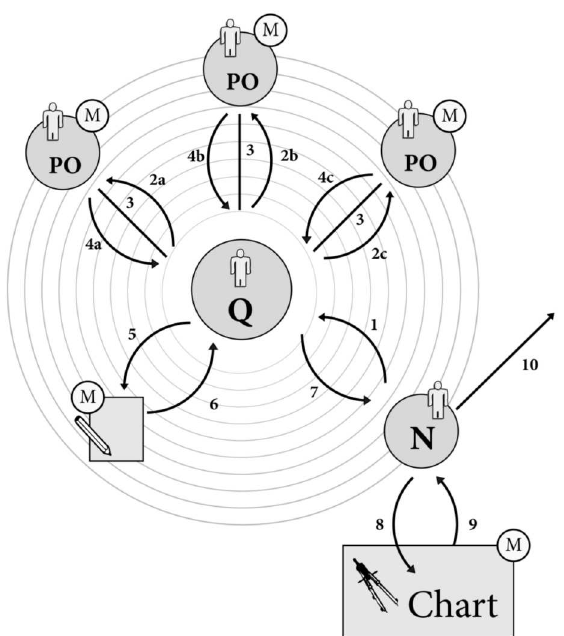
Figure 1. Position fixing based on visual bearing performed by a navigation team on board of a sea vessel as an example of distributed